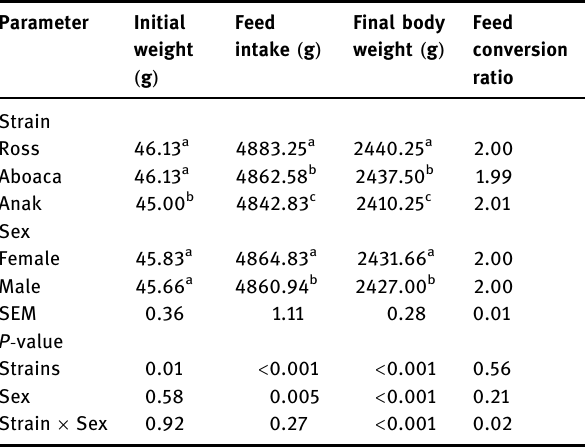
Table 2: Strain × sex e ff ect on growth performance indicators